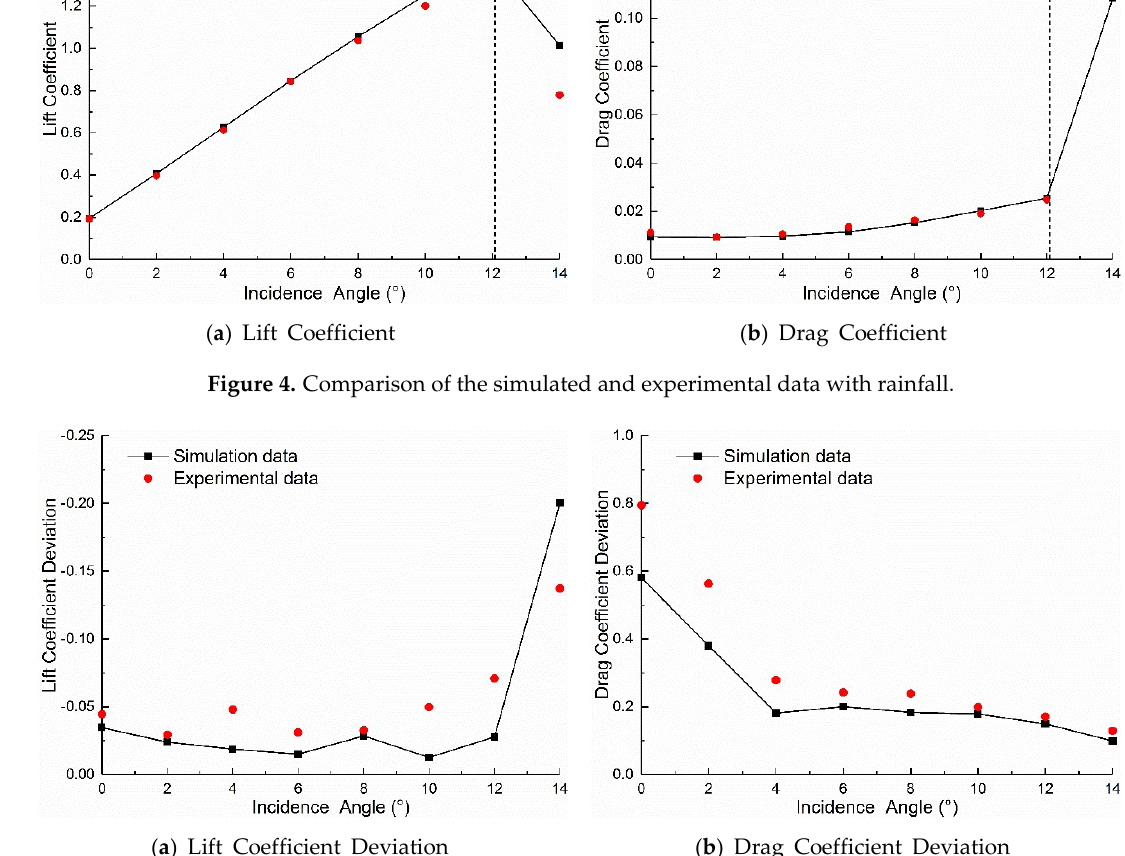
Figure 5. Relative deviations between rain and no rain